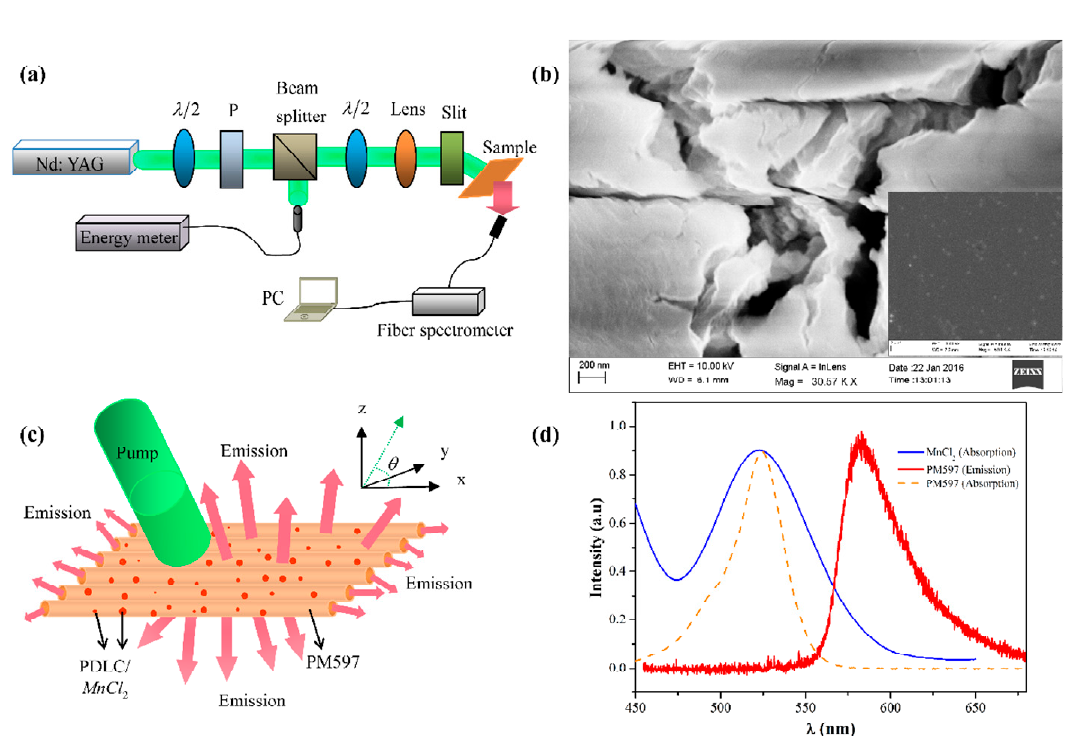
Figure 1. ( a ) Experimental setup for measuring random lasing spectra; ( b ) SEM image of solid MnCl 2 ·4H 2 O. Inset: SEM image of water-solution of MnCl 2 , where spots with average diameter 250 nm are MnCl 2 ; ( c ) Schematic diagram of lasing emission in the sample; ( d ) Red line is spontaneous emission spectrum of PM597, blue line is absorption spectra of MnCl 2 and dotted line is